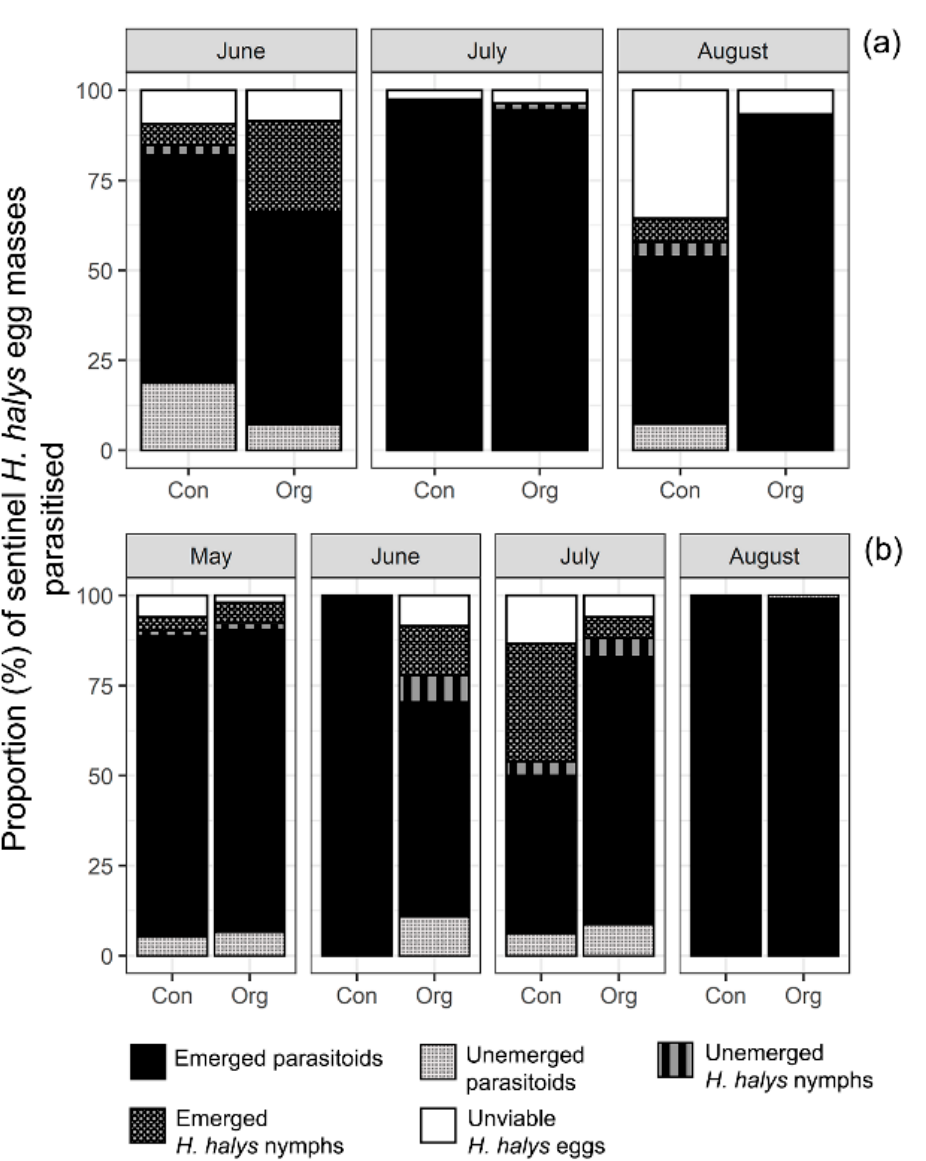
Figure 2. Relative proportion of parasitoids and H. halys nymphs development per parasitised egg masses (raw data) recovered in organic (Org) and conventional (Con) kiwifruit orchards in Mei County, Shaanxi Province, China during egg parasitoid surveys in: ( a ) 2018 and ( b ) 2019. Arithmetic means are shown without standard errors (SEs) to allow visualization, as the underlying distribution are not Normal.